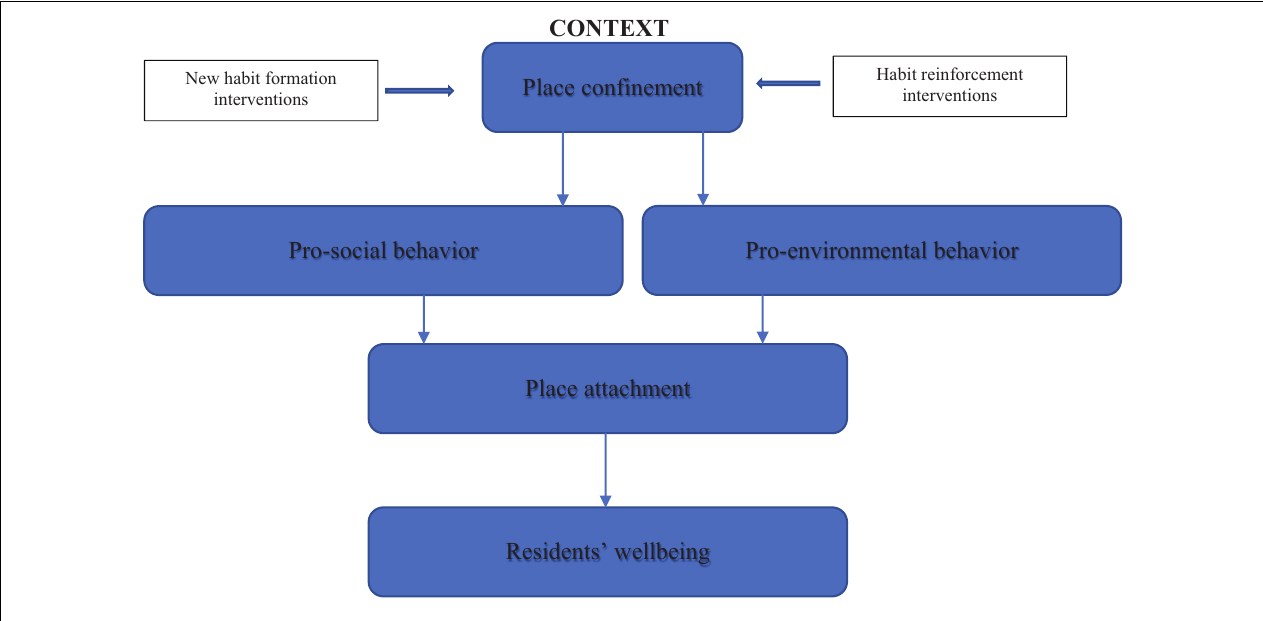
FIGURE 1 | The proposed theoretical